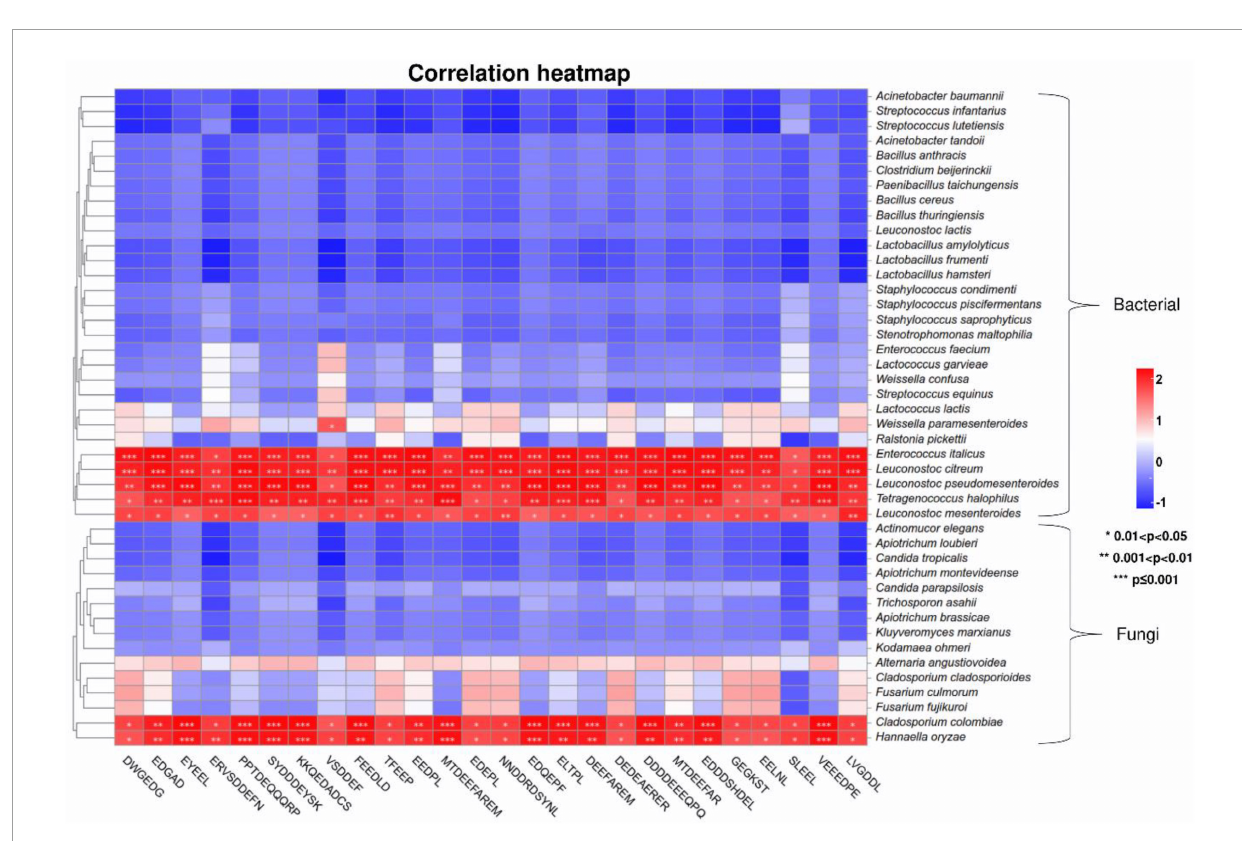
FIGURE7 Clustering heatmaps based on Pearson’s correlation tests between the umami peptides and microorganisms based on species